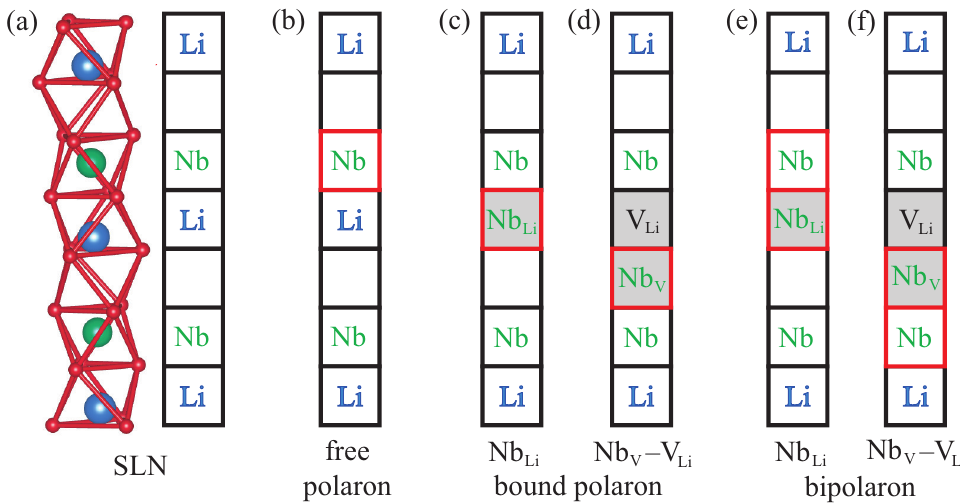
Figure 1. Stacking order of lithium niobate: Stoichiometric crystal ( a ), free polaron ( b ), bound polaron at a Nb Li antisite ( c ) or a Nb V –V Li defect pair ( d ), bipolaron at a Nb Li antisite ( e ) or a Nb V –V Li defect pair ( f ). Black squares represent oxygen octahedra, while red squares indicate the formation of a (bi)polaron at this site. Gray fillings highlight deviations from the stoichiometric